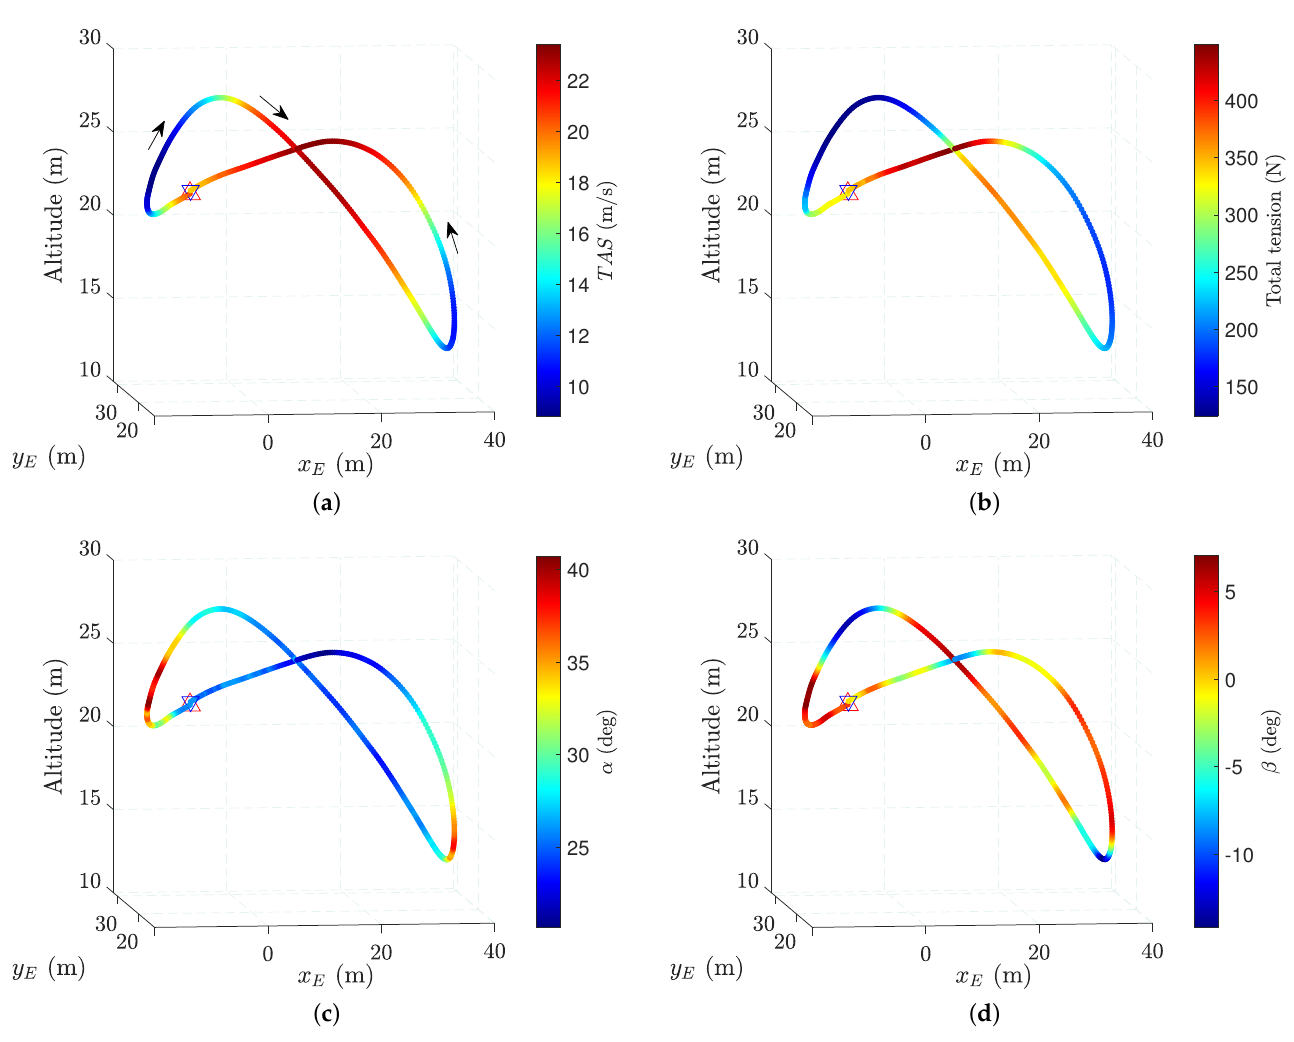
Figure 2. Trajectory of the kite in the selected maneuver. The color in ( a – d ) correspond to the true airspeed, the total tension on the two tethers, the angle of attack and the sideslip angle, respectively. The upward red triangle and the downward blue triangle are the starting and final points and the arrows in ( a ) show the direction of the kite